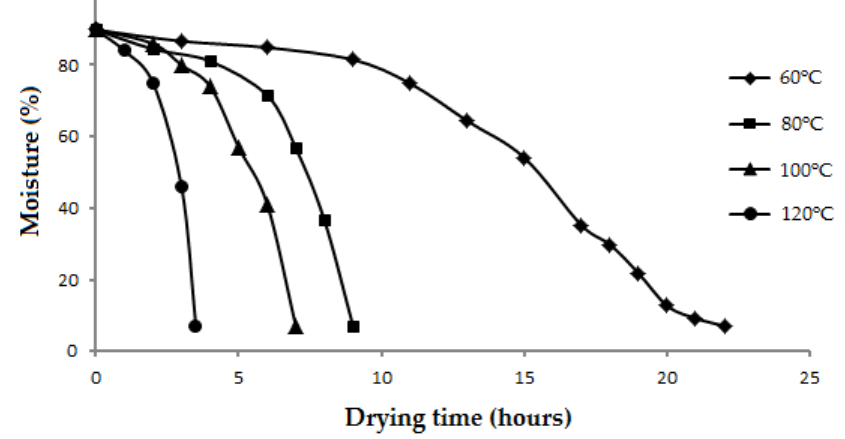
Figure 1. Drying curves of Roselle at different temperatures.